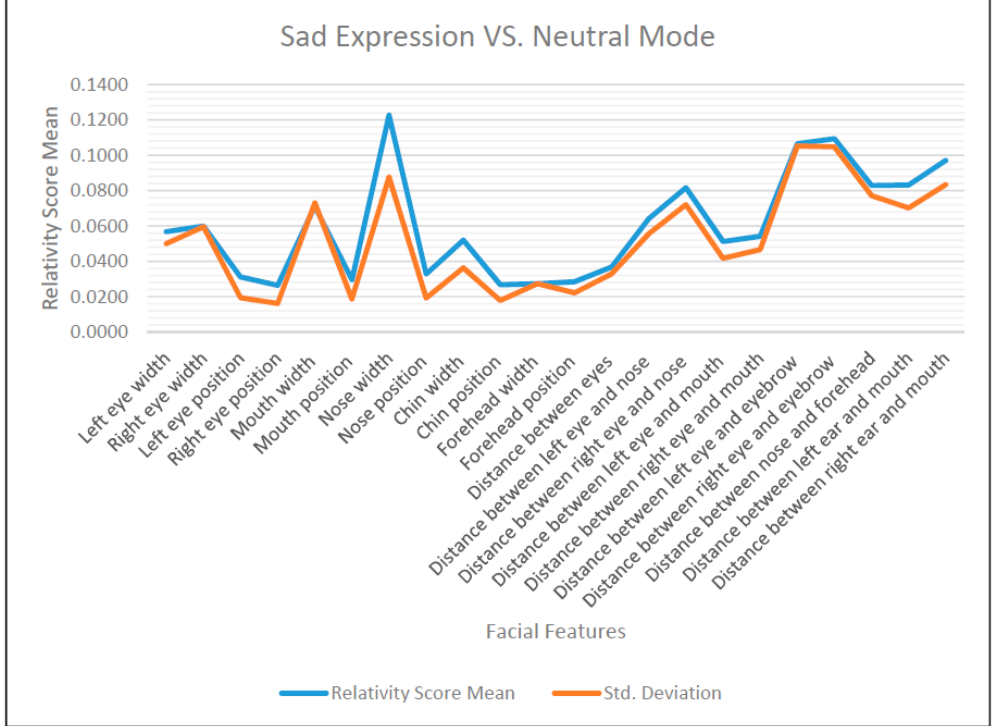
Figure 15. The means of RSS between sad expression and neutral mode of facial features for 36 subjects.